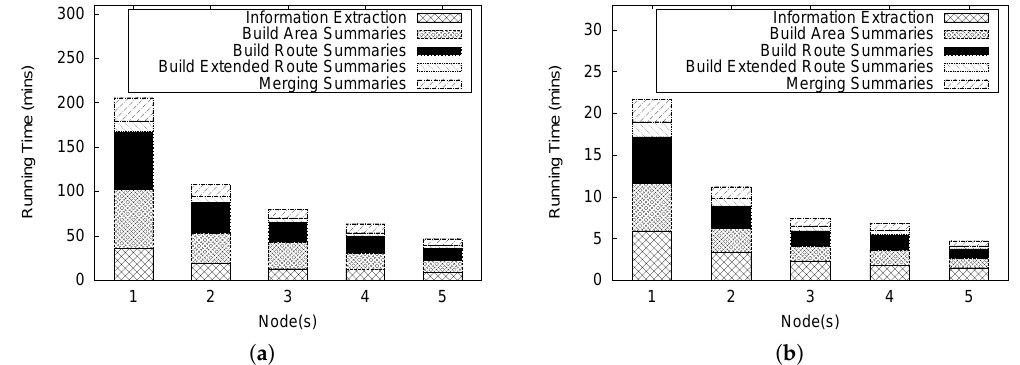
Figure 24. Scalability of the Distributed PQ-index Construction. ( a ) NewYork dataset; ( b ) Chicago